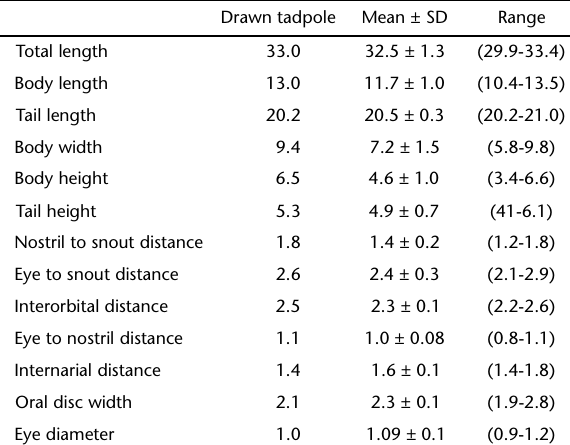
Table I. Measurements of Proceratophrys izecksohni larvae. Measurements for the illustrated tadpole (UNIRIO 4010, stage 35) with mean ± standard deviation (SD) are provided below as well as the range among the tadpoles used in the description (n = 10, stages